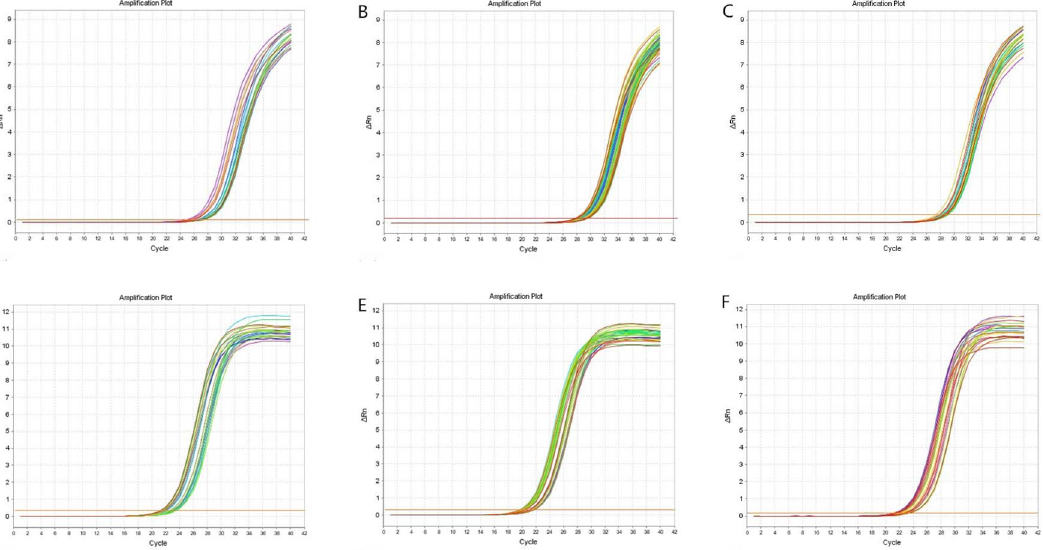
Figure 1. Amplification curves. A: IL-10, the Ct value was within the range of 24–27; B: IL-12, the Ct value was within the range of 26–28; C: IL-16, the Ct value was within the range of 26–28; D: IL-18, the Ct value was within the range of 20–22; E: IL-17, the Ct value was within the range of 20–22; and F: IL-27, the Ct value was within the range of 21–23. doi:10.1371/journal.pone.0101324.g001 PLOS ONE |